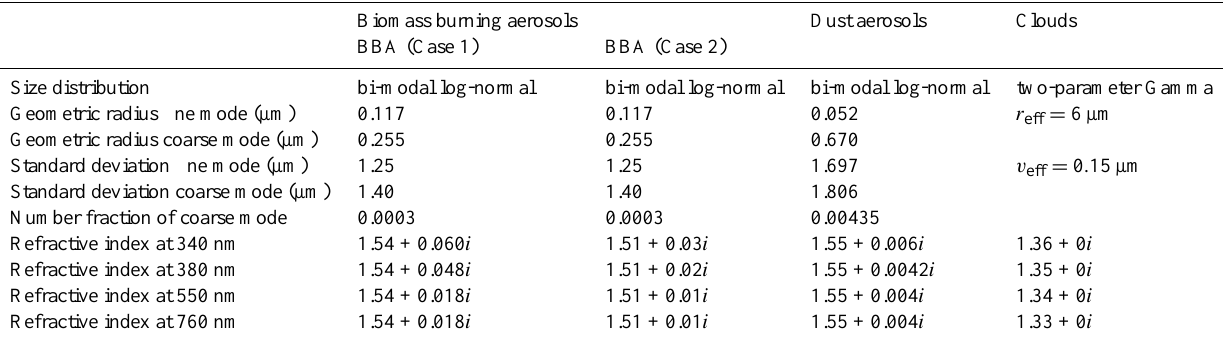
Table 1. Aerosol and cloud microphysics models used in the Mie calculations. r eff : effective radius of cloud droplet size distribution, v eff : effective variance of cloud droplet size distribution.